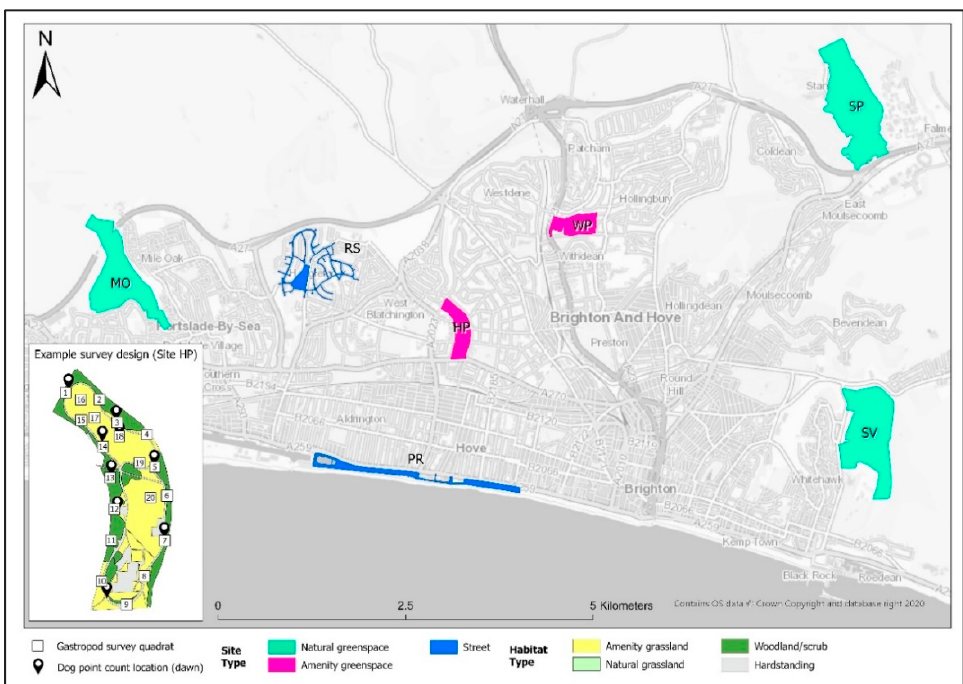
Figure 1. Field sites across the city of Brighton and Hove, England, UK and surrounding areas where quadrat and point count transect surveys were conducted for gastropod (mollusca) and dog ( Canis lupus familiaris ) occurrence under different spatiotemporal and environmental conditions.